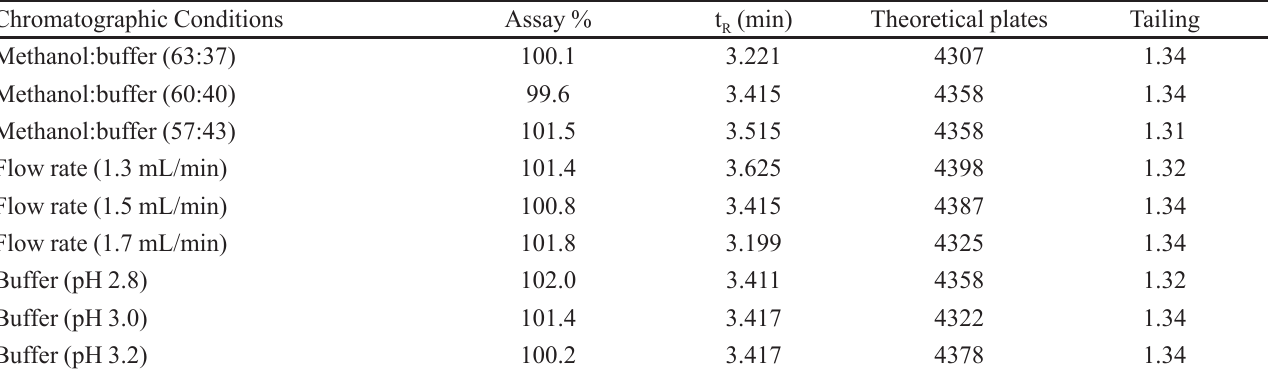
TABLE III - Robustness study of sparfloxacin Chromatographic